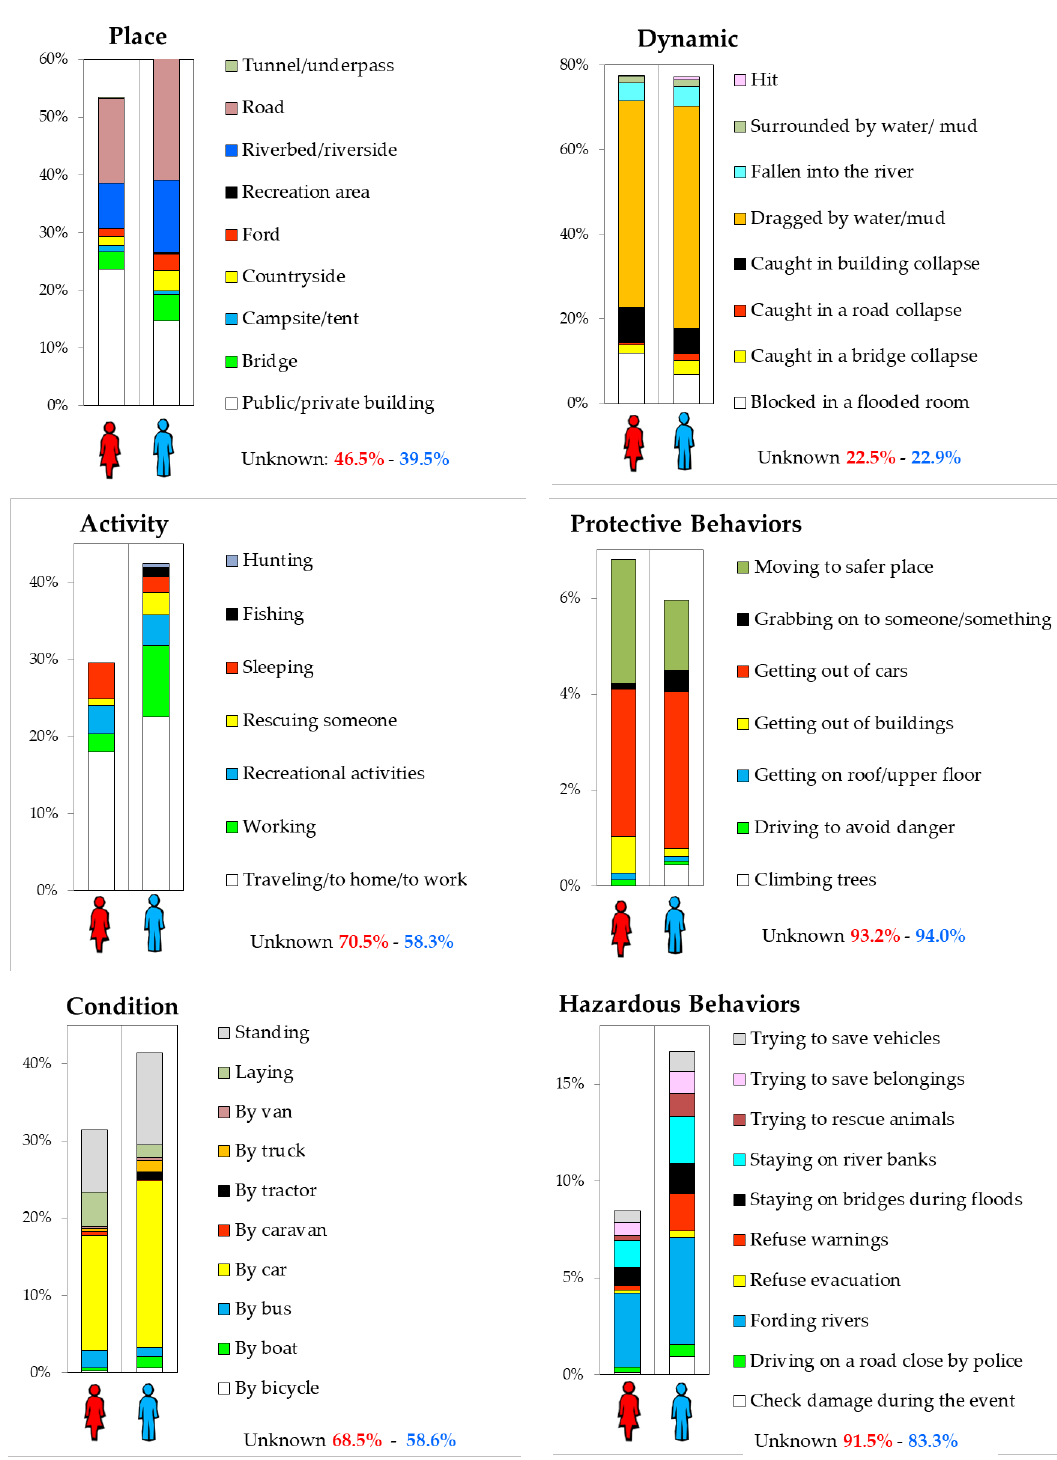
Figure 6. Relationships between gender and place, activity, condition, dynamic, protective, and hazardous behavior, for the victims of known gender (1936, 78.5% of FF). Unknown percentages are in red for females and blue for males.